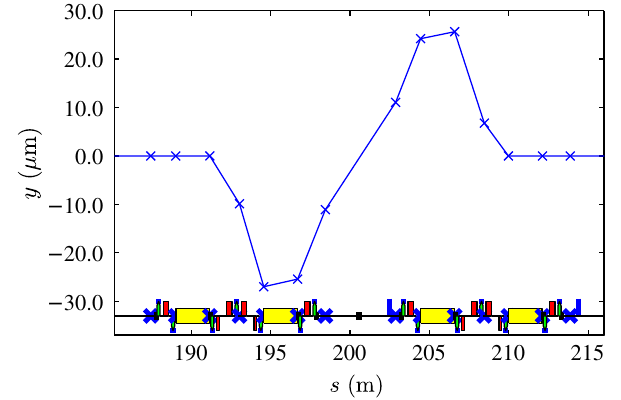
FIG. 10. Simulation of an example orbit bump using six vertical correctors, resulting in angle υ ¼ 5 μ rad within the insertion at the longitudinal position s ¼ 200 m. Longitudinal positions of AS storage ring multipole magnets are indicated